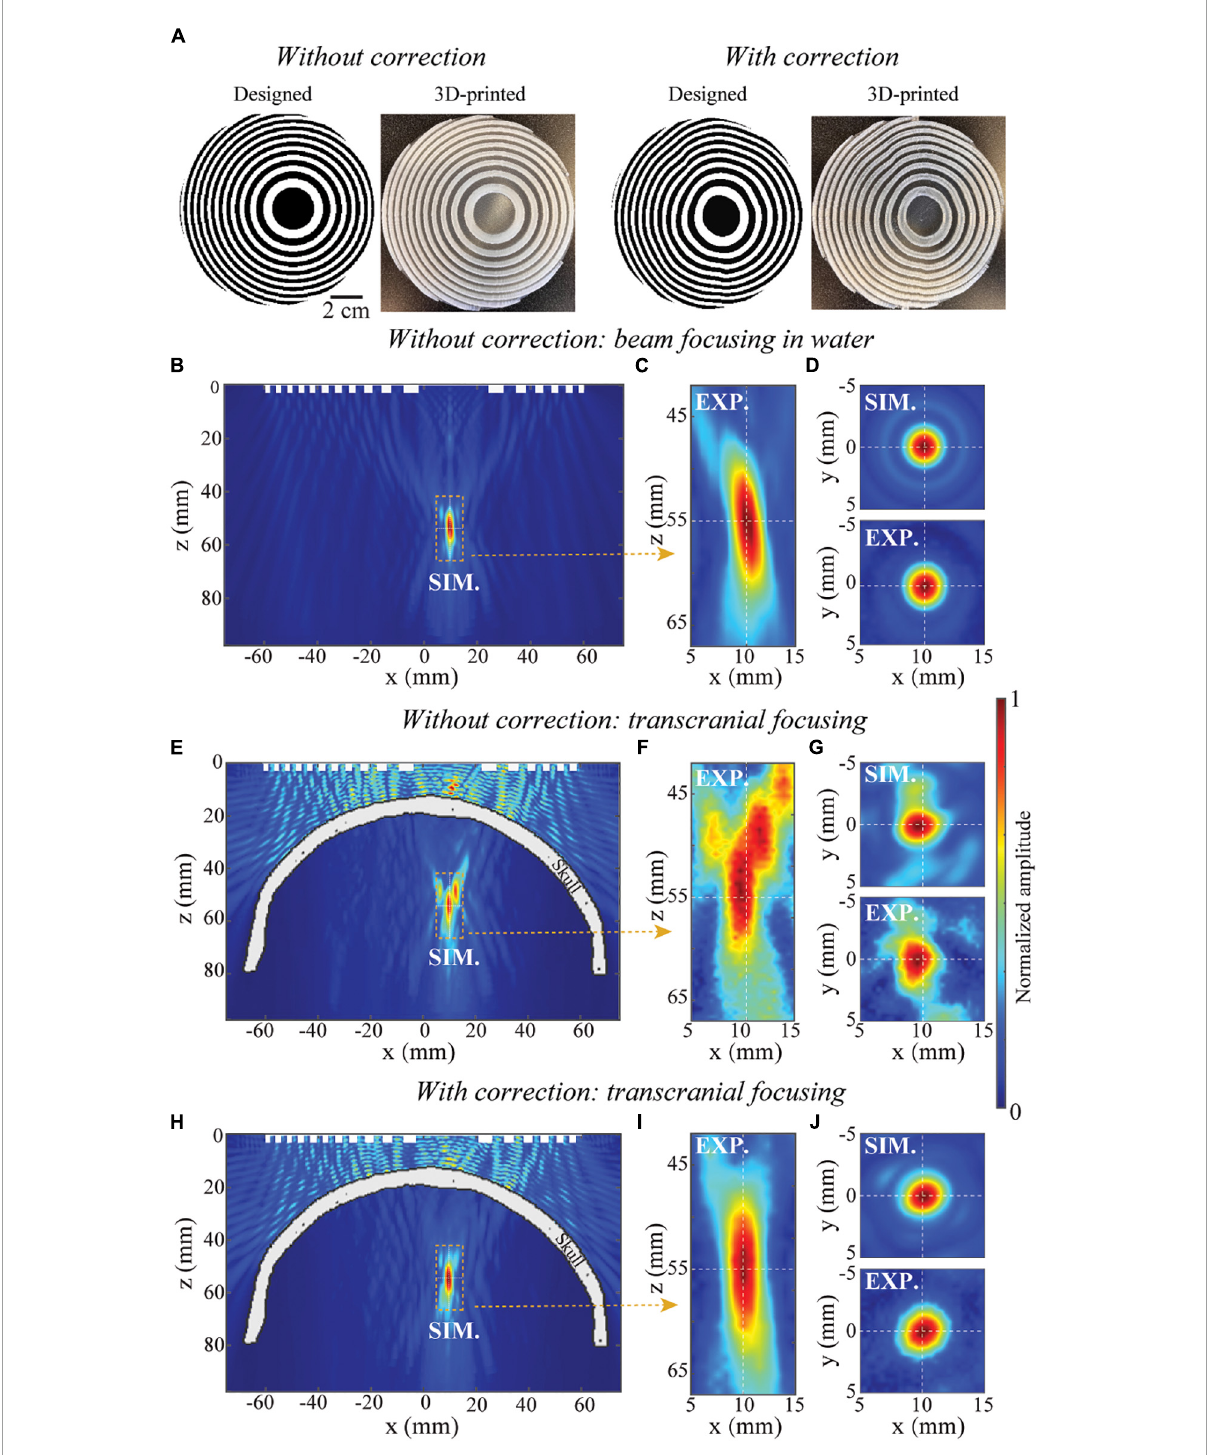
FIGURE3 Single-focus BAM for tFUS. (A) The designed and 3D-printed BAMs without and with skull aberration correction, respectively. The white and black unit represent units “ π /2” and “0”. (B,C) Simulated (SIM) and experimental (EXP.) calibration of pressure distribution along xz-plane (axial view) of beam focusing in homogenous media, (D) the corresponding simulated and experimental pressure distribution along xy-plane (transverse view). (E,F) Simulated and experimental calibration of pressure distribution along xz-plane of transcranial focusing using the lens without correction, (G) the corresponding simulated and experimental pressure distribution along xy-plane. (H,I) Simulated and experimental calibration of pressure distribution along xz-plane of transcranial focusing using the lens with correction, (J) the corresponding simulated and experimental pressure distribution along xy-plane. The pressure fields are normalized to the peak